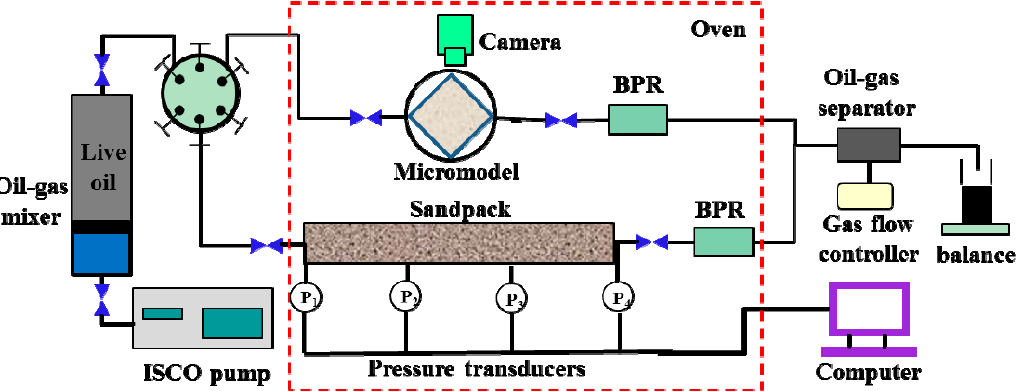
Figure 1. Schematic diagram of depletion experiment in the sandpack and micromodel.